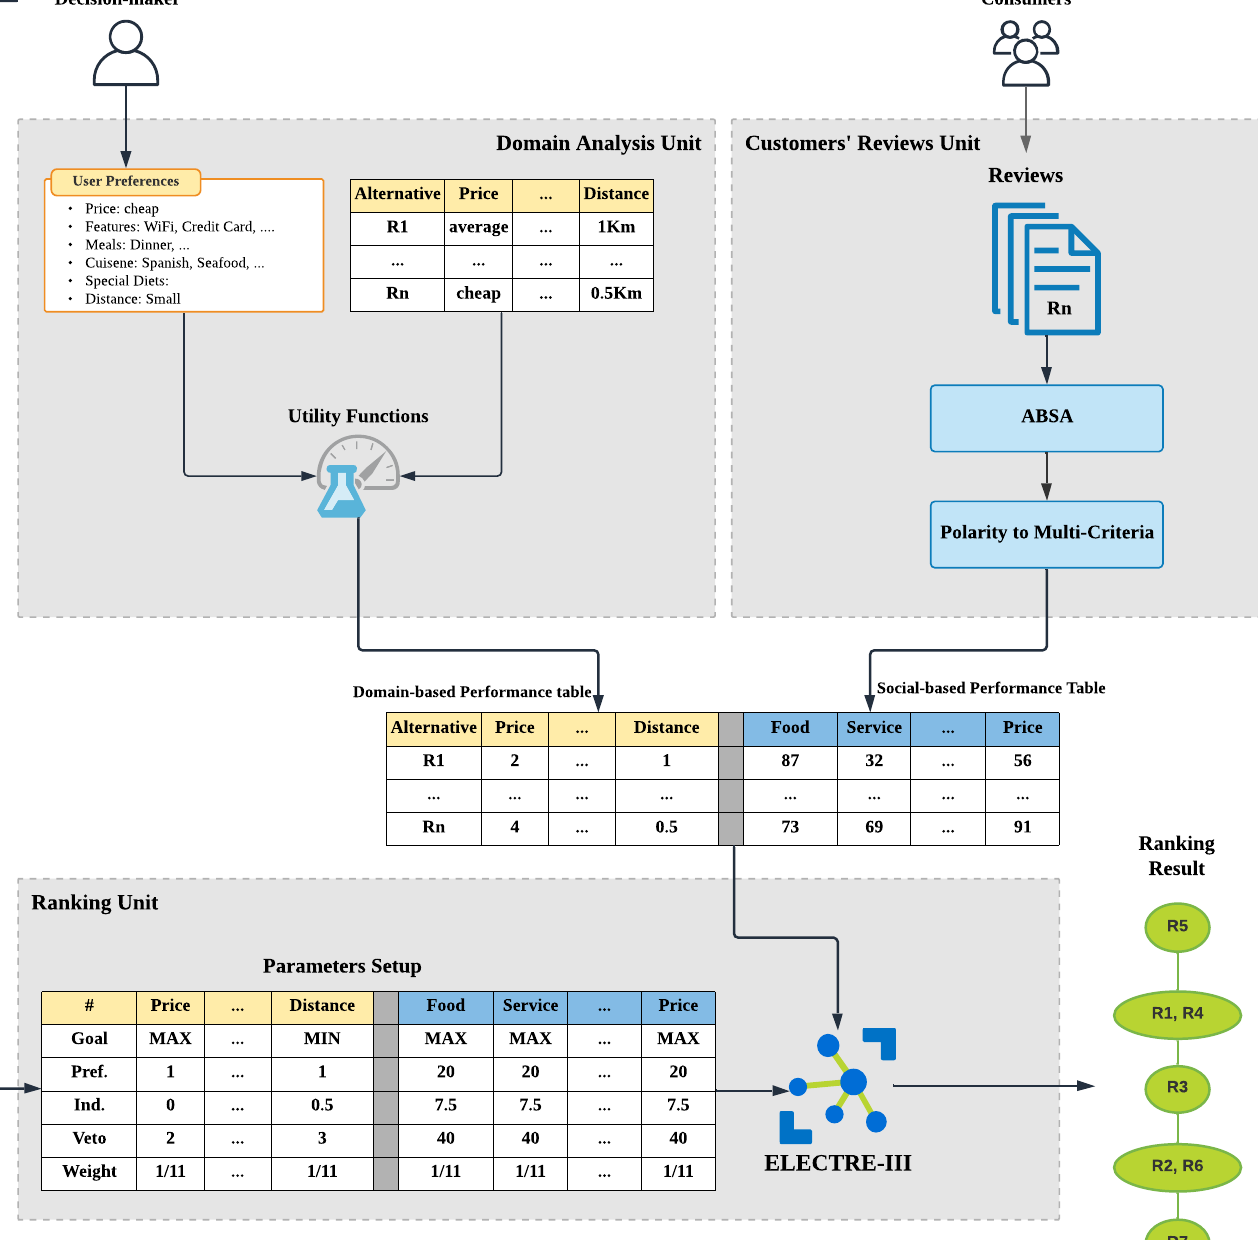
Social-based Performance TableDomain-based Performance table